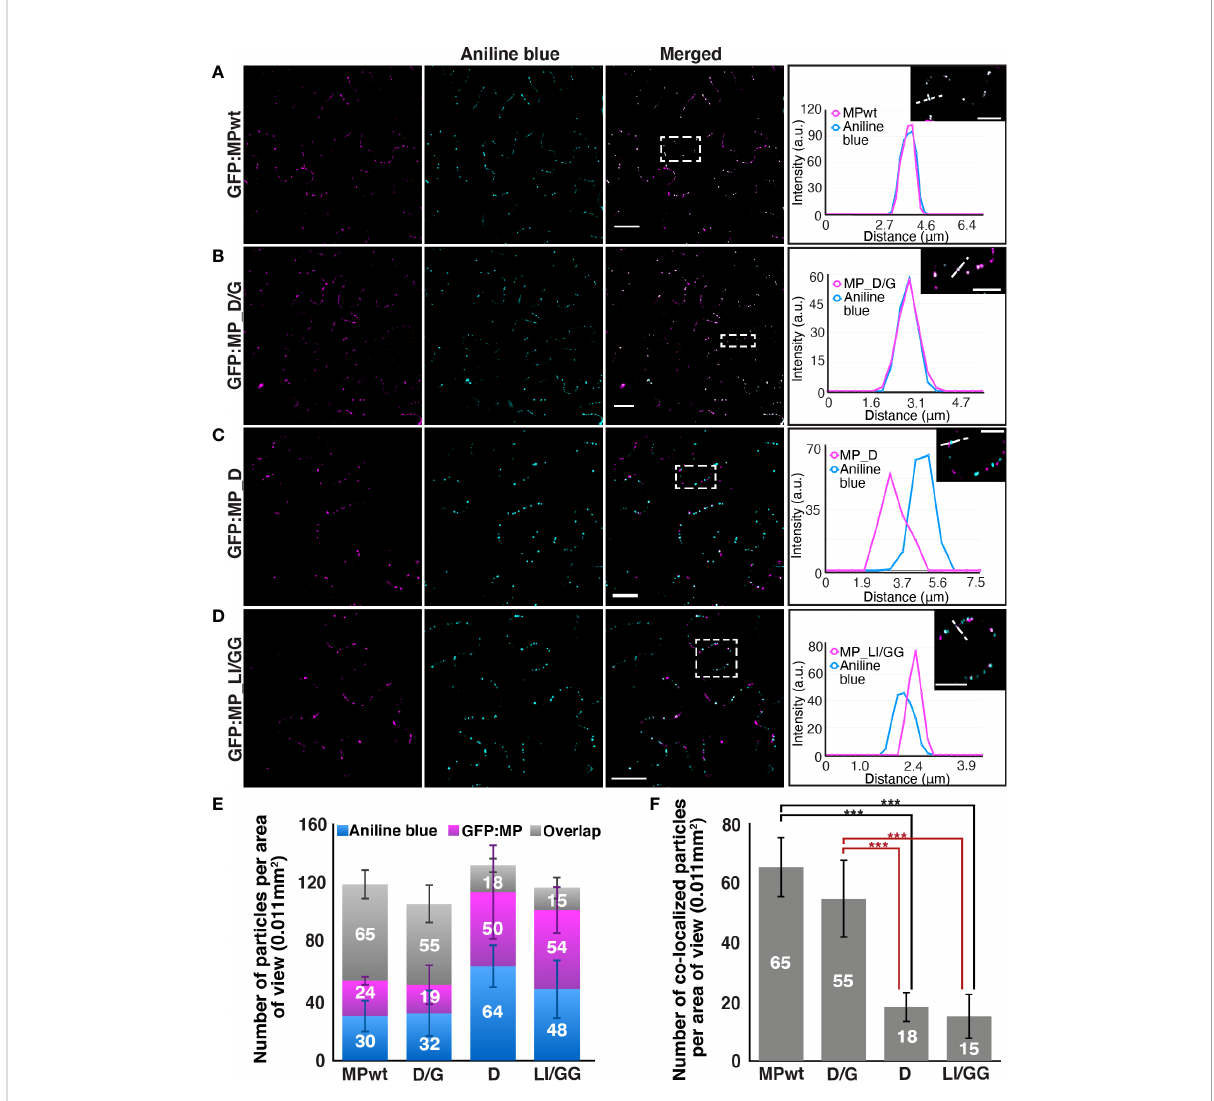
FIGURE 5 Movement de fi cient LL motif MP mutants do not localize to callose deposits. N. benthamiana epidermal cells expressing (A) GFP : MPwt or GFP : MP mutants, (B) GFP : MP_D/G, (C) GFP : MP_D, and (D) GFP : MP_LI/GG (magenta) with RdRp and CP. Aniline blue was used to mark callose deposits (cyan). Selected regions (white rectangles) show the intensity pro fi le of the diagonal line generated from images that were adjusted to a lower intensity by ImageJ. Images represent single optical planes. Scale bar, 20 m m, 10 m m (magni fi ed region). (E) The quanti fi cation of callose deposits (blue), punctate structures labeled by OuMV GFP : MPwt or GFP : MP mutants (magenta), and co-localized spots (gray) per area of view. The spots were counted using the ComDet v.0.4.1 plugin in ImageJ. At least six areas of view were examined (n ≥ 6) and the total number of counted spots for each sample is more than 700. Stacked bar graph represents mean ± standard deviation (F) The statistical analysis of co-localized spots in (E) . Bar graph represents PD-localized OuMV GFP : MPwt or GFP : MP mutants per area of view (mean± standard deviation, n ≥ 6). *** P < 0.001 by ANOVA, followed by Tukey ’ s